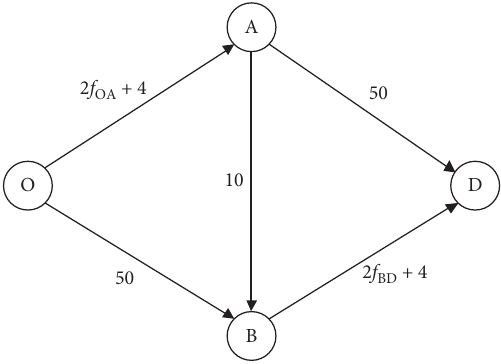
Figure 1: Experimental traffic